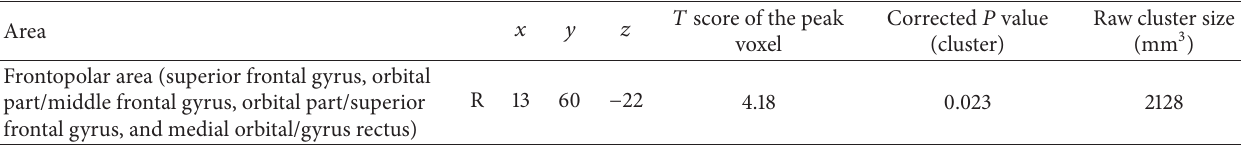
Figure 2: Practice-related performance increase in (a) paper-and-pencil tasks and (b) computerized tasks after FSNC training. Both paper- and-pencil and computerized tasks consisted of addition, subtraction, and multiplication tasks. Practice resulted in a significant increase in performance across all training tasks (in paper-and-pencil tasks, performance was measured in terms of the largest number of items answered in one trial; in the computerized tasks, performance was measured in terms of the shortest interstimulus interval (ISI) of blocks in which participants answered correctly in more than half of trials) from the first to the last day of training (one-tailed paired 𝑡 test, 𝑃 < 0.001 ). Error bars represent standard errors. Table 2: Brain regions with a significant greater decrease in rGMV in FSNC